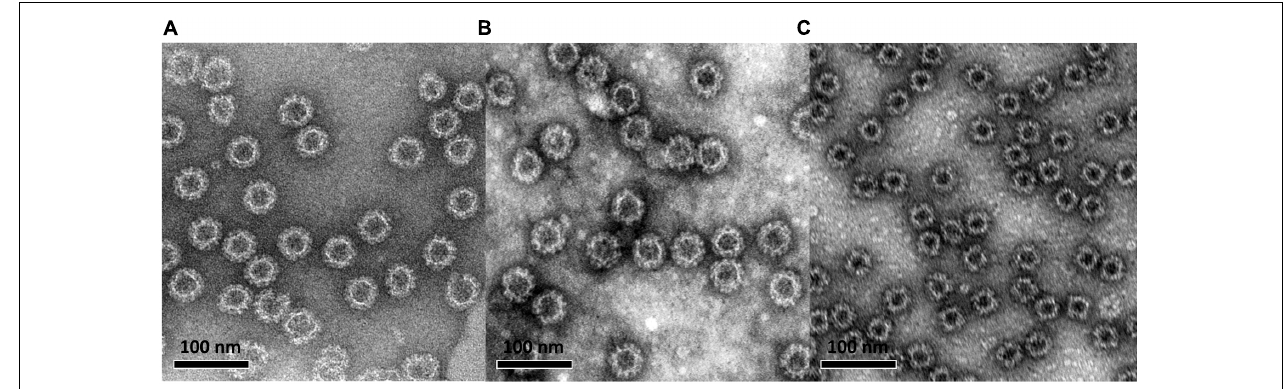
FIGURE 1 | Electron microscopy image of baculovirus-insect cell system-produced and sucrose gradient-purified norovirus GII.4-99 (A), GII.4 Sydney (B), and GI.3 (C) virus-like particles (VLPs). VLPs were negatively stained with 3% uranyl acetate (pH 4.5) and the preparations were examined using an FEI Tecnai F12 electron microscope at a magnification of 23,000 ×